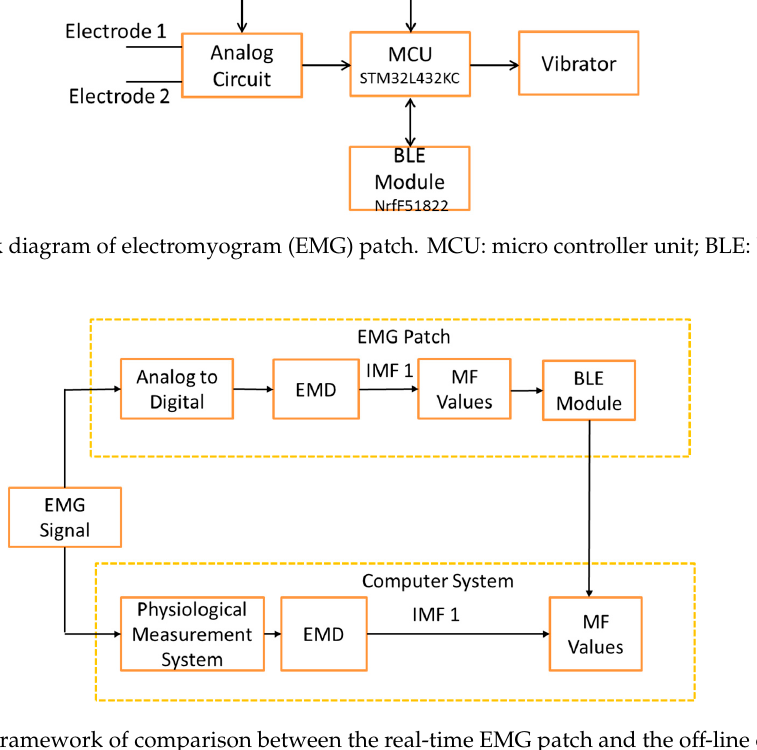
Figure 2. The framework of comparison between the real-time EMG patch and the off-line computer system. EMD: empirical mode decomposition; MF: median frequency.